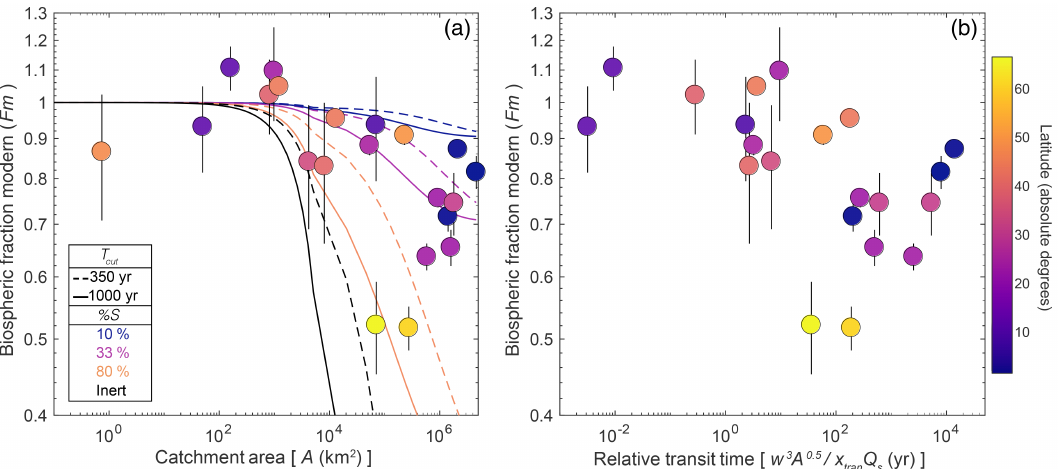
Figure 5. Field data compilation and comparison with model predictions. Field data are color coded based on their latitude as a proxy for POC cycling rates. (a) Model curves and field measurements of the relationship between catchment area and bulk biospheric Fm. Model curves are drawn for fixed POC consumption rate constants but variable steady-state proportions of “slow” cycling POC and T cut values (see legend). (b) Measured biospheric Fm values compared to our relative transit time metric (Eq. 16), which is based on Hack’s law (Hack, 1957) and the scaling relationships shown in Figs. 2 and 3. The field data are consistent with the model predictions of aged POC in rivers with larger catchment areas and slower migration rates (inferred from variations in w 3 /Q s ) and thus longer sediment storage times. We note that in our compilation of rivers with measurements of biospheric Fm, catchment area and w 3 /Q s are